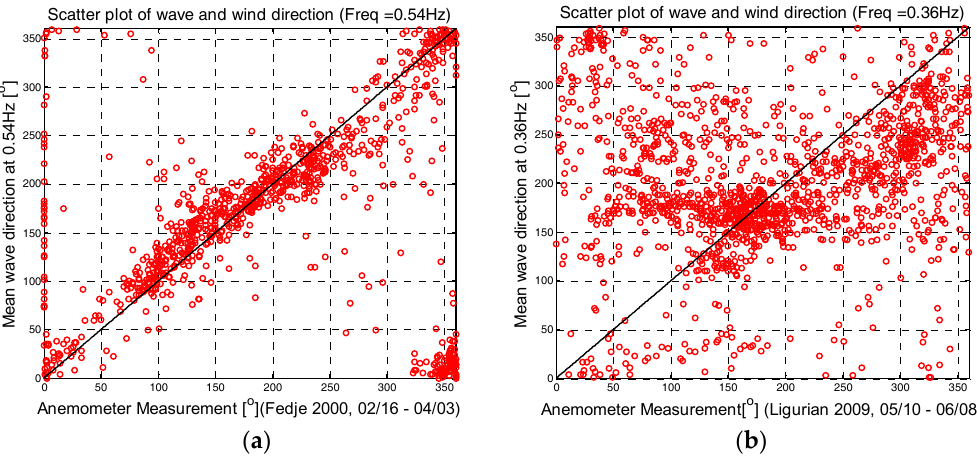
Scatter plot of wave and wind direction (Freq =0.36Hz)